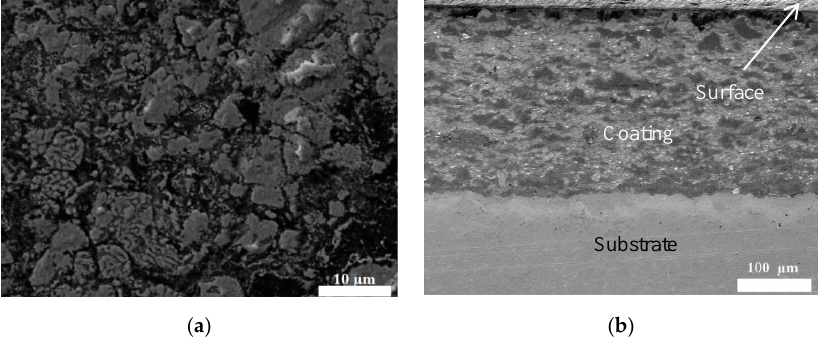
Figure 1. The surface and cross-sectional micro-morphology of the Zn-Al-Mg-TiO 2 composite coating: ( a ) surface micro-morphology; ( b ) cross-sectional micro-morphology.